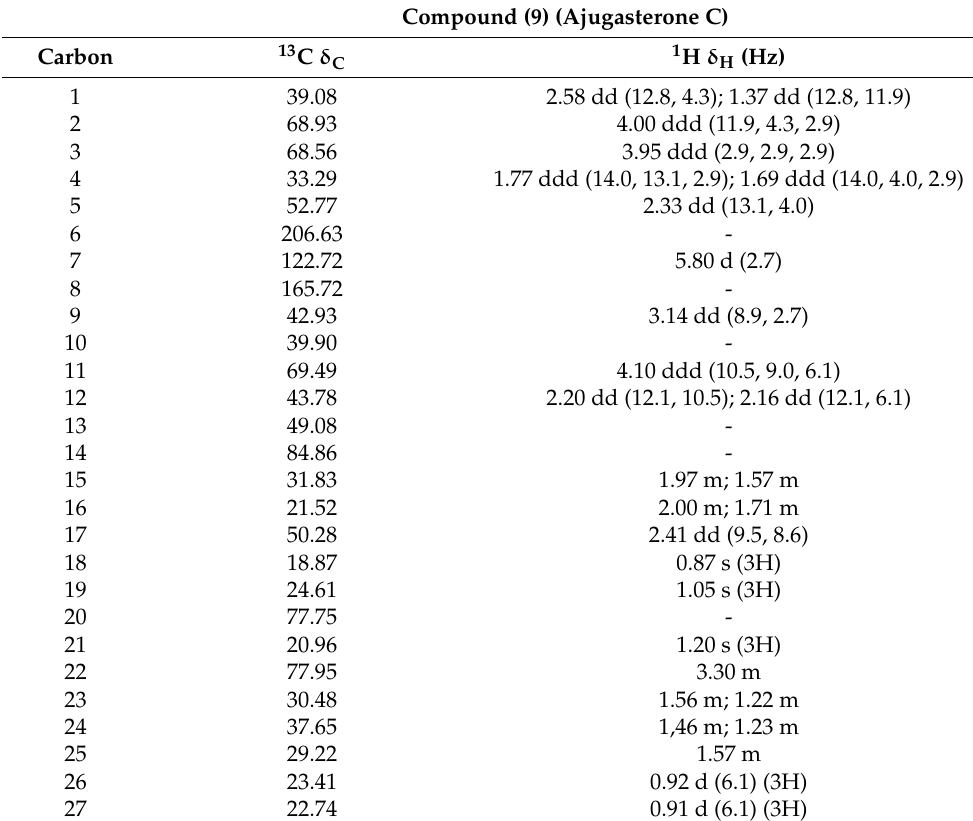
Table 2. NMR Data of Compound 9